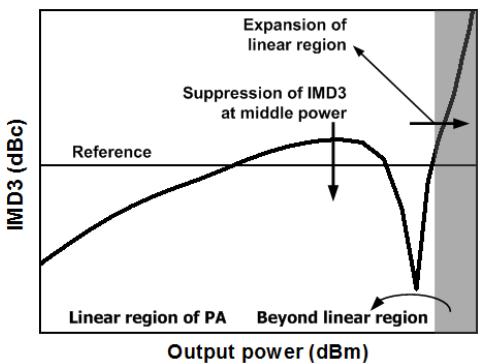
Figure 2. Conceptual diagrams of IMD3 of power amplifier (PA).